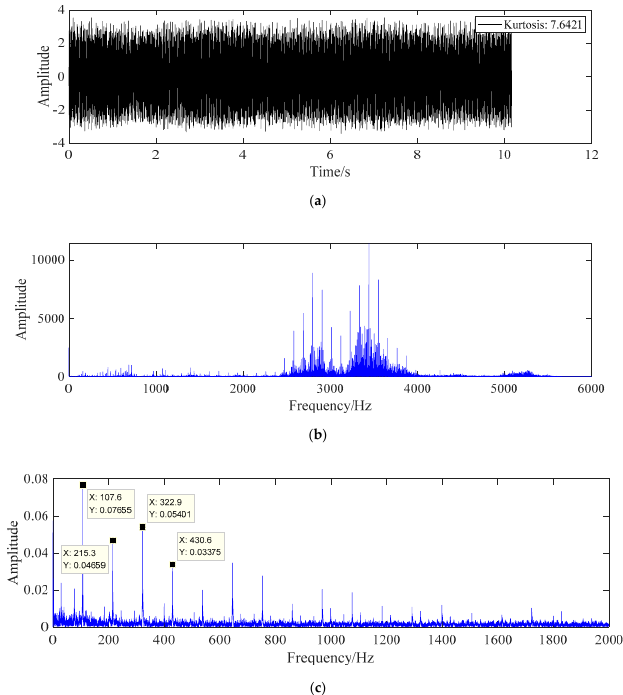
Figure 10. The fault diagnosis diagram of fault data B. ( a ) Time domain diagram of fault data B. ( b ) Frequency domain diagram of fault data B. ( c ) Fault data B whitening energy operator frequency domain graph.